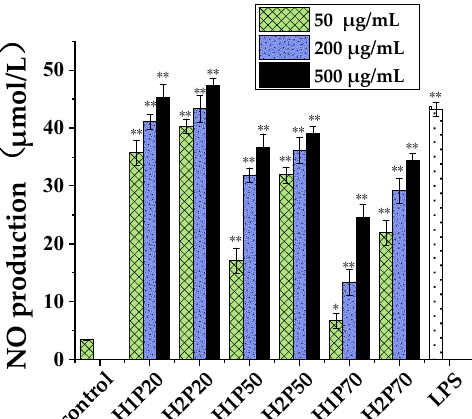
Figure 5. Effects of polysaccharides extracted from the fruiting bodies of H. erinaceus on NO production from RAW264.7 macrophage cells. Control: phosphate buffer; LPS: lipopolysaccharide, positive control (1 µ g/mL). H1P20 (H1P50, H1P70): 20% (50%, 70%) ethanol precipitated polysaccharides from the original H. erinaceus ; H2P20 (H2P50, H2P70): 20% (50%, 70%) ethanol precipitated polysaccharides from the ARTP mutagenic H. erinaceus . Each value represents the mean ± SD. * p < 0.05, ** p < 0.01 compared to the negative control (PBS treatment).